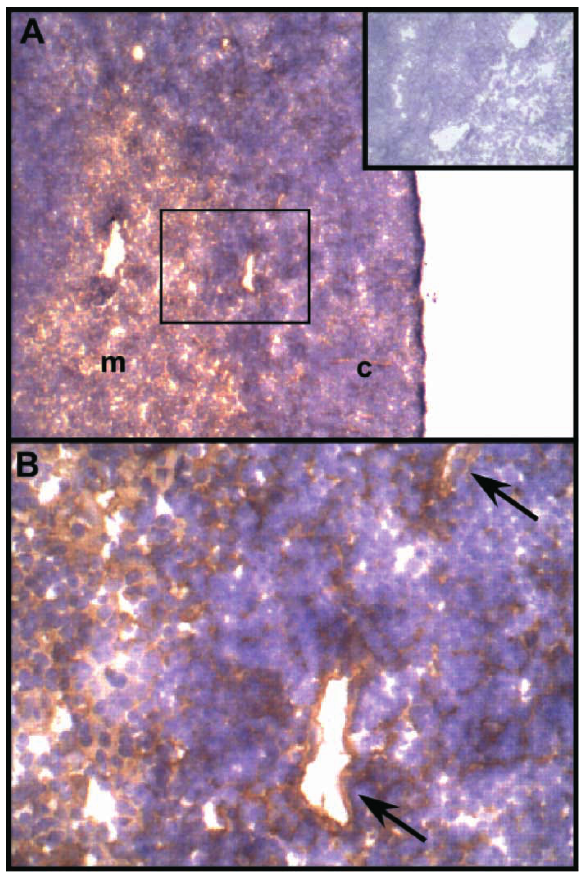
FIGURE 3 ICAM-1 is expressed by endothelial and stromal cells in the mouse thymus. Panel A shows a low magnification (100 £ ) image of ICAM-1 immunohistochemical staining; inset shows an isotype-matched antibody control. Staining was strongest in the medulla and lower in the cortex, but was basically expressed throughout the thymus. No differences were found with respect to thymic homing potential (see text). The area indicated by a rectangle is enlarged in a high power (400 £ original magnification) image in B. A few post-capillary vessels are indicated by arrows; some of these show a distinction in the intensity of staining between luminal and abluminal aspects (see text). M ¼ medulla, C ¼ cortex.